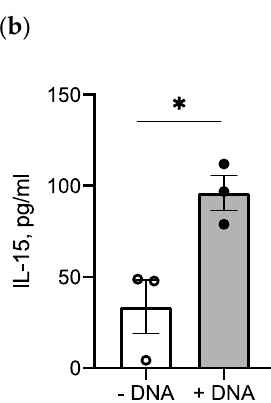
Figure 5. Validating expression of transgenes in gene-edited T cells: ( a ) Representative flow graph of GFP expression in gene-edited T cells 12 days post-electroporation; right panel, overall knock-in efficiency of the transgene after knock-in optimization as determined by flow cytometry of GFP+/TCR αβ - cells ( n = 7). ( b ) IL-15 production from gene-edited T cells was detected by ELISA 8–10 days post-electroporation ( n = 3, two-tailed t-test, * p = 0.024).